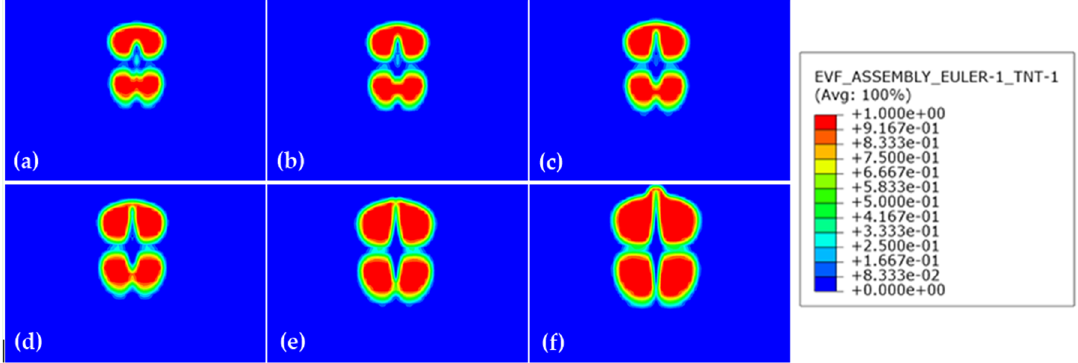
Figure 29. Simulated bubble motion during the collapse phase at: ( a ) t =6.05 ms; ( b ) t = 6.10 ms; ( c ) t = 6.15 ms; ( d ) t = 6.20 ms; ( e ) t = 6.35 ms; and ( f ) t = 6.60 ms.